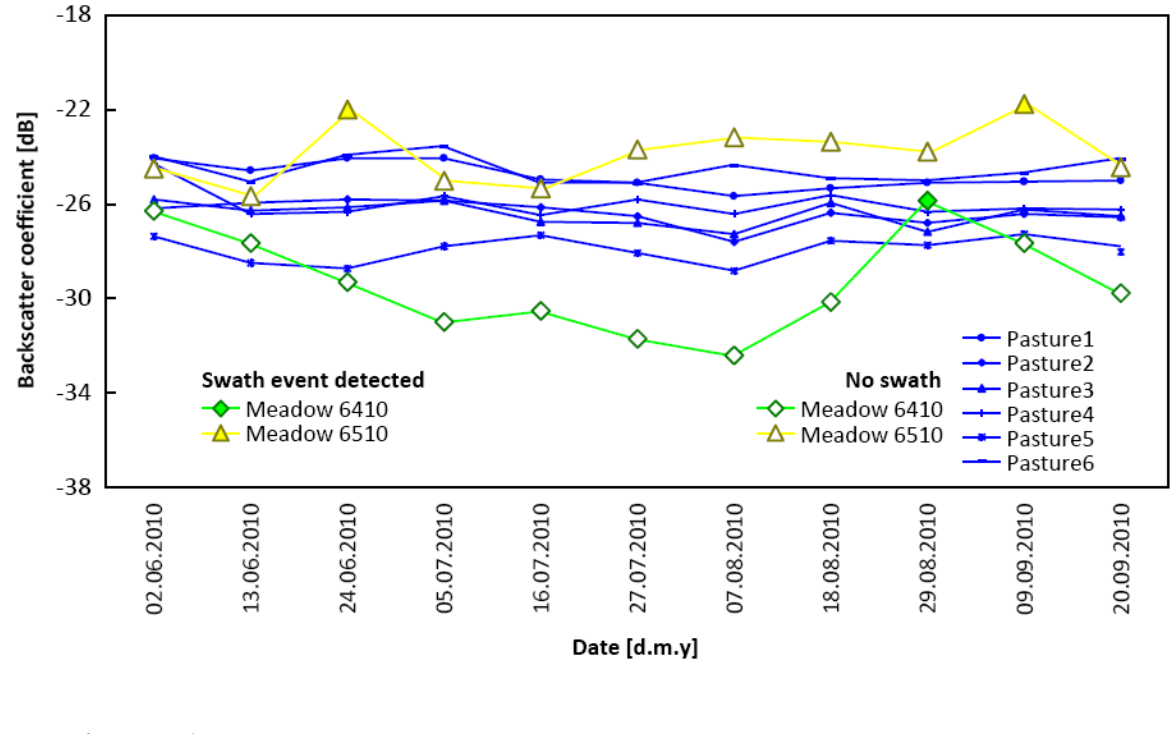
Figure 2. Temporal profiles of the mean backscatter coefficient (σ°) and detected swath events (highlighted) for the investigated NATURA 2000 grassland sites as well as different pasture sites. Respective standard deviations and sample sizes within the training fields are 7.9 dB and 2982 pixels (Meadow 6410), 13.7 dB and 3199 pixels (Meadow 6510), 4.8 dB and 2487 pixels (Pasture 1), 5.5 dB and 70,000 (P2), 5.6 dB and 118,000 (P3), 5.1 dB and 111,000 (P4), 6.3 dB and 12,000 (P5) and 8.1 dB and 76,500 pixels